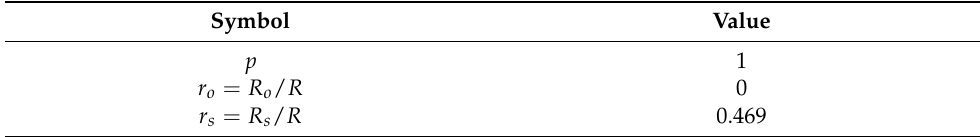
Table 5. Optimal geometry data and optimal performances of the